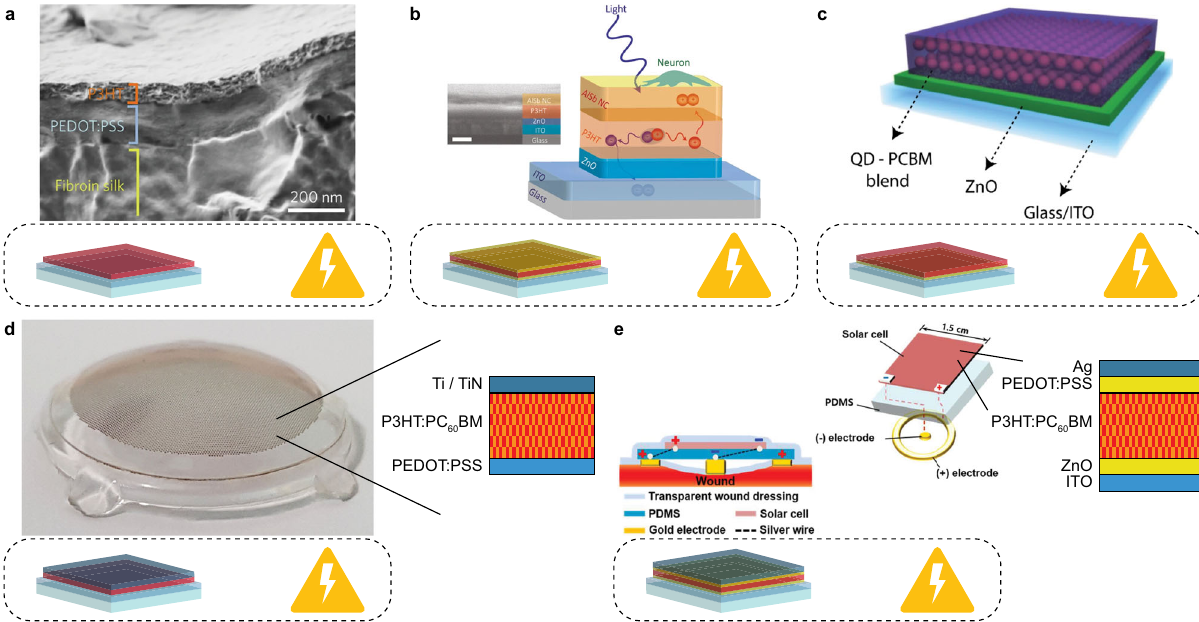
Fig. 2 Conductor/semiconductor and conductor/semiconductor/conductor bioelectronic interfaces. a – c Representative examples of conductor/ semiconductor devices for neuromodulation. a Scanning electron microscopy image of a fully organic retinal prosthesis for arti fi cial vision. Implantation in the subretinal space restored visual functions in blind rats. Image reprinted by permission from Springer Nature 32 . b Photovoltaic interface based on aluminium antimonide nanocrystals for the capacitive stimulation of primary neurons. The scale bar in the insert is 200 nm. Image adapted under